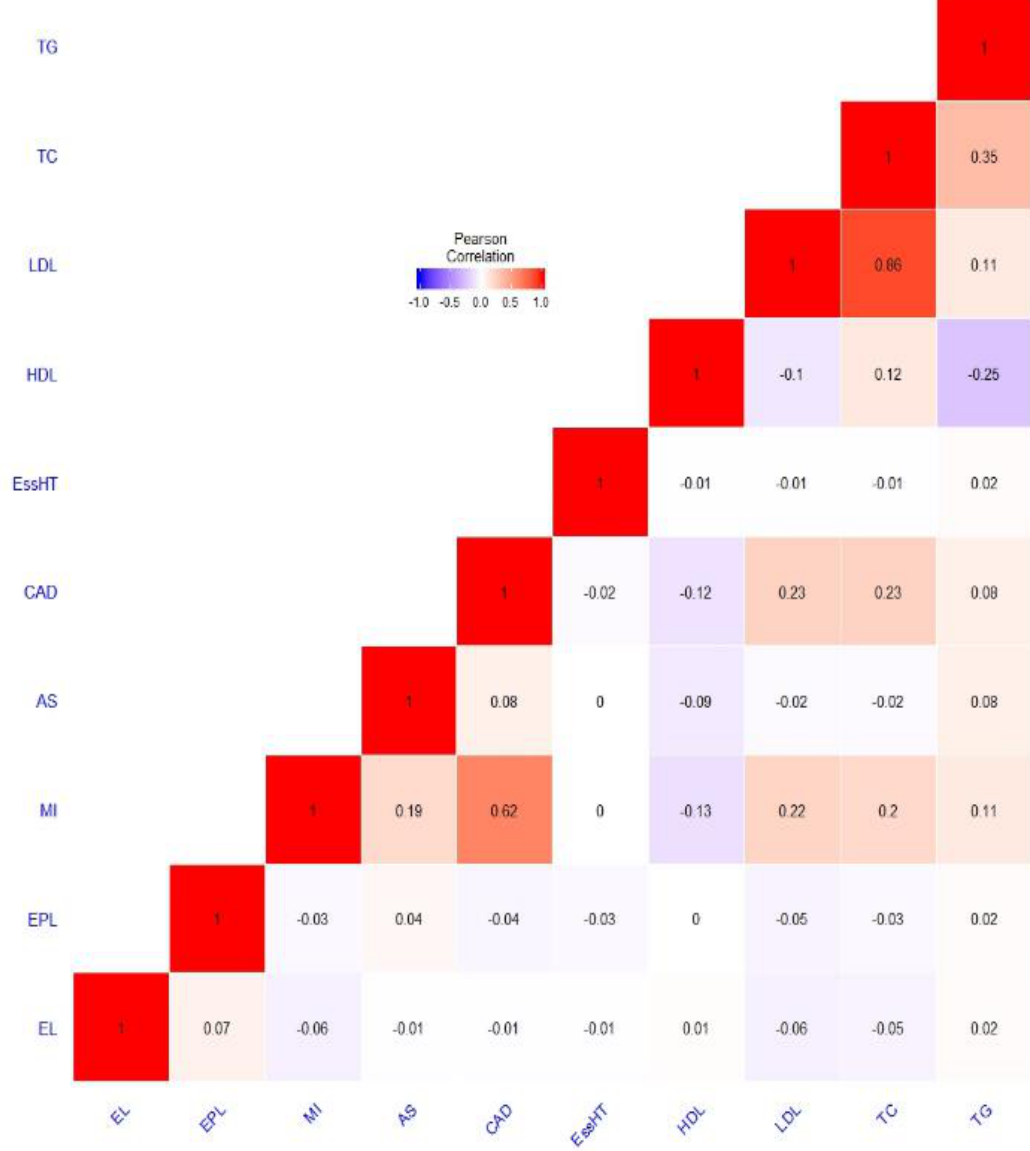
Figure 3. Pearson’s r correlation matrix comparing the genetic overlap between the investigated Figure 3. Pearson ’ s r correlation matrix comparing the genetic overlap between the investigated PRS.